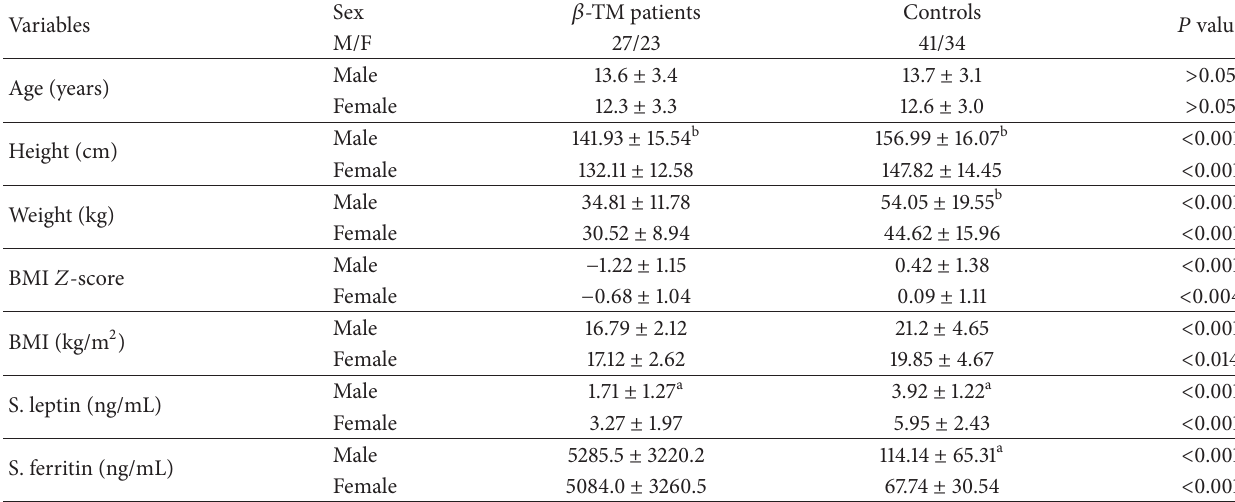
Table 1: Serum leptin, ferritin, age, weight, height, BMI 𝑍 -score, BMI, and IGF-1 in 𝛽 -TM patients and controls according to sex. Variables